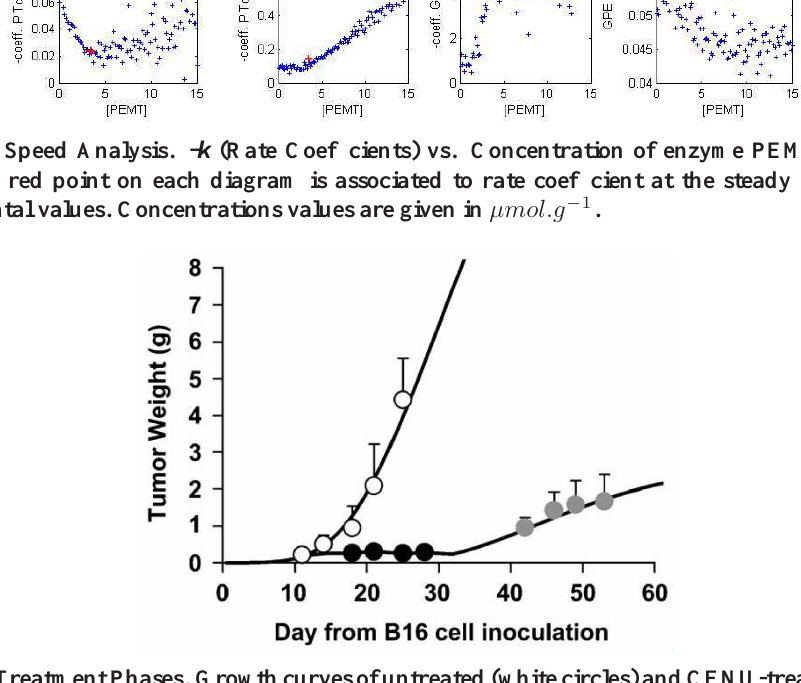
Figure 6: Treatment Phases. Growth curves of untreated (white circles) and CENU-treated tumors during the growth inhibition phase to treatment (black circles) and the growth recovery phase (gray circles). CENU was given intratumorally at days 11, 14, and 18. Bars,